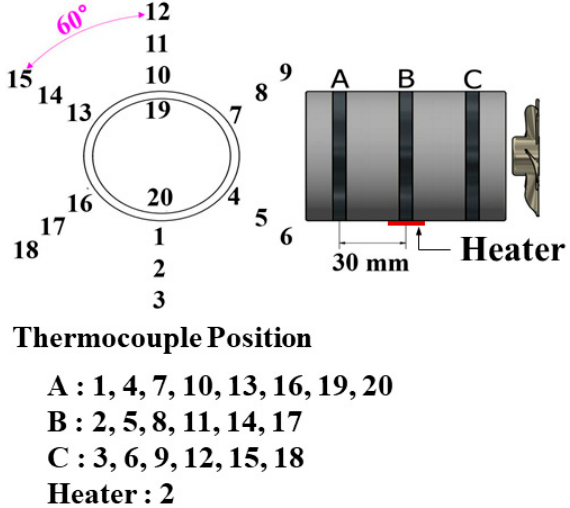
Figure 4. Thermocouple positions of the CAHP.